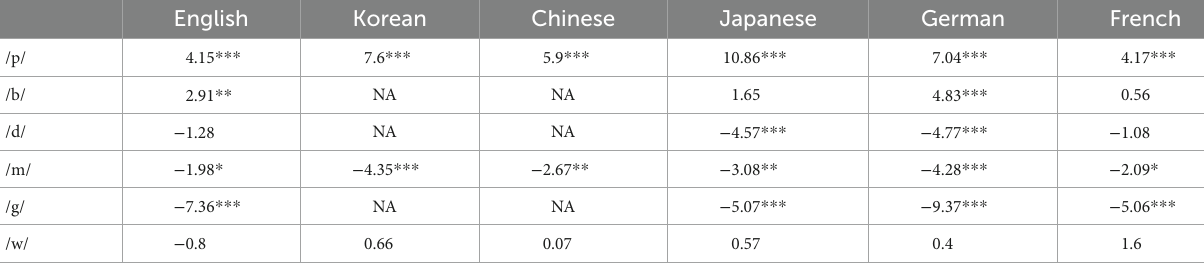
TABLE 6 Z-scores for the regression analyses for the six phonemes across the six